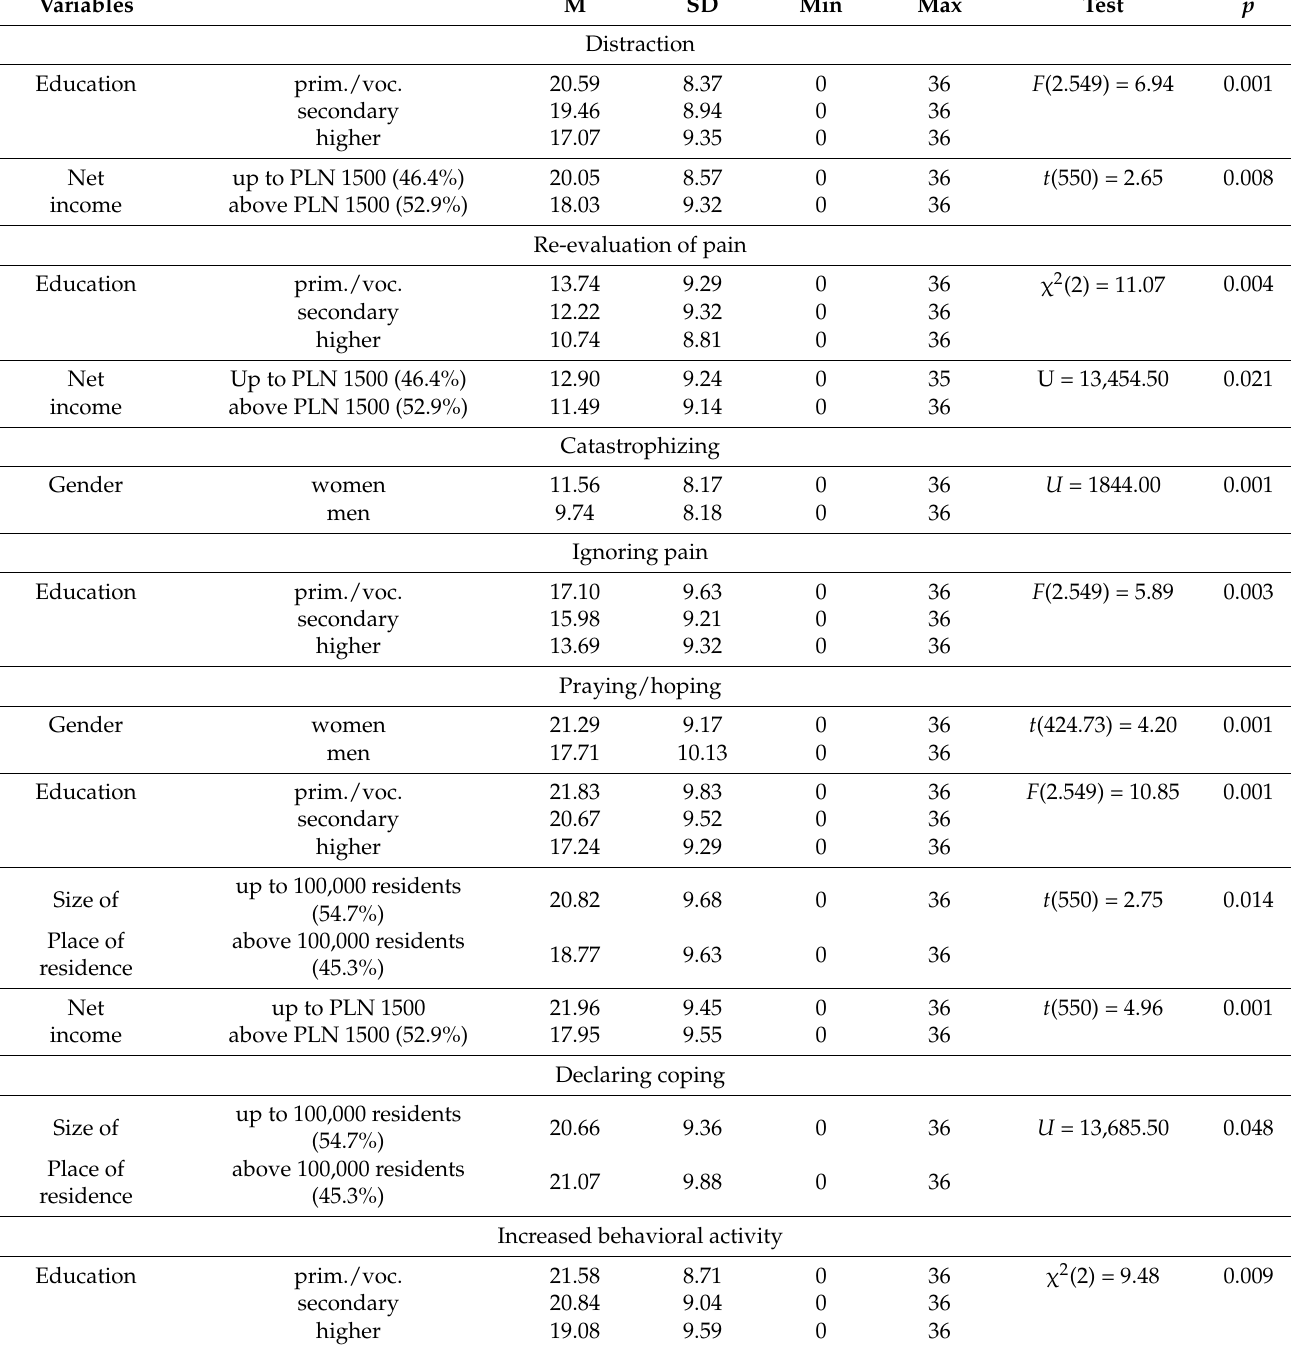
Table 4. Socioeconomic variables that differentiate CSQ test